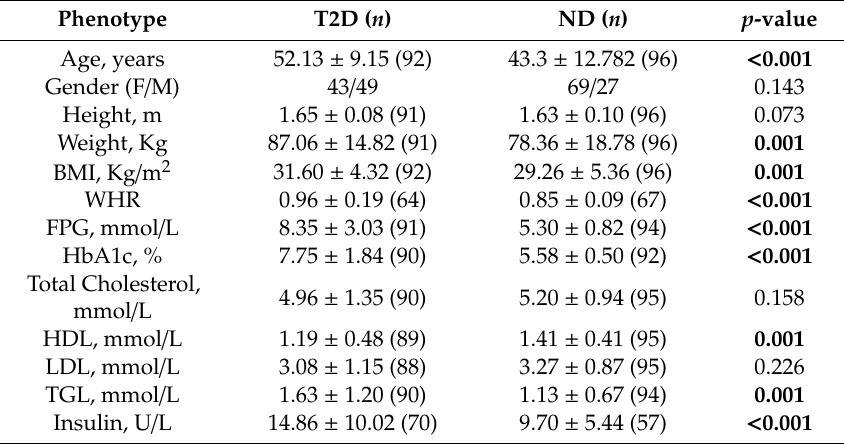
Table 1. Demographic and baseline characteristics of the study population ( n = 188).